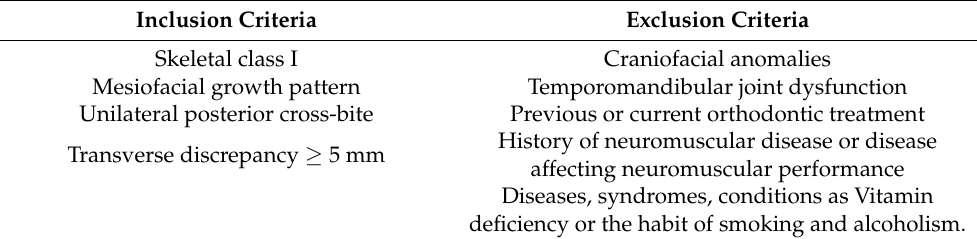
Table 1. Criteria for inclusion and exclusion in the study.